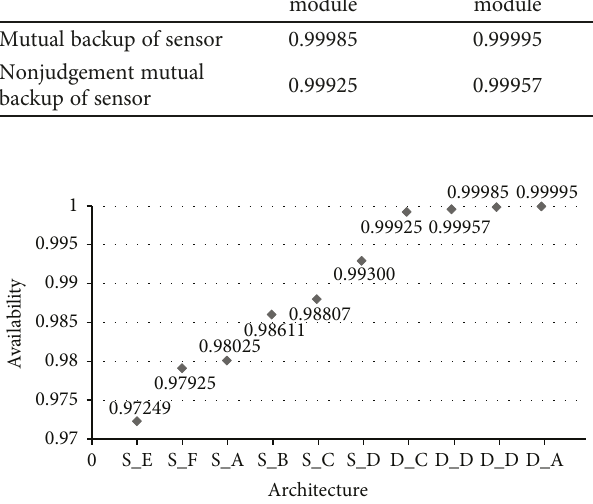
Figure 17: Availability comparison of di ff erent display function